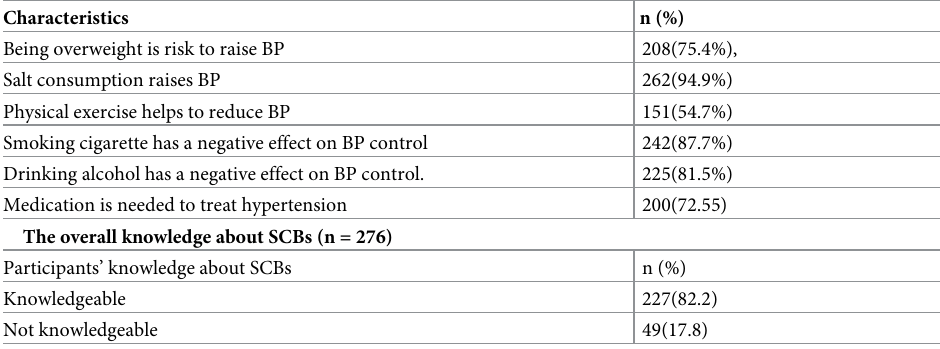
Table 4. Participants’ knowledge about the impact of SCBs on BP control among hypertensive patients in ACSH, 2017 (n = 276).